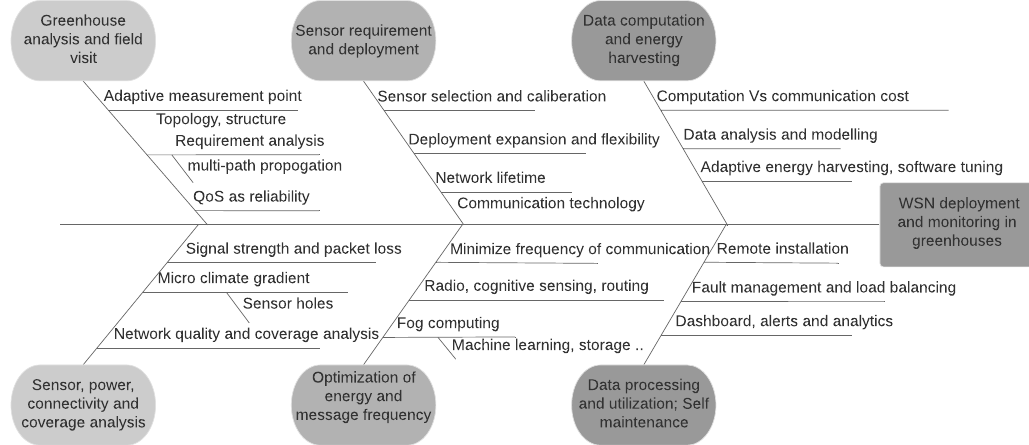
Figure 3. Sequential steps for WSN deployment and monitoring in a